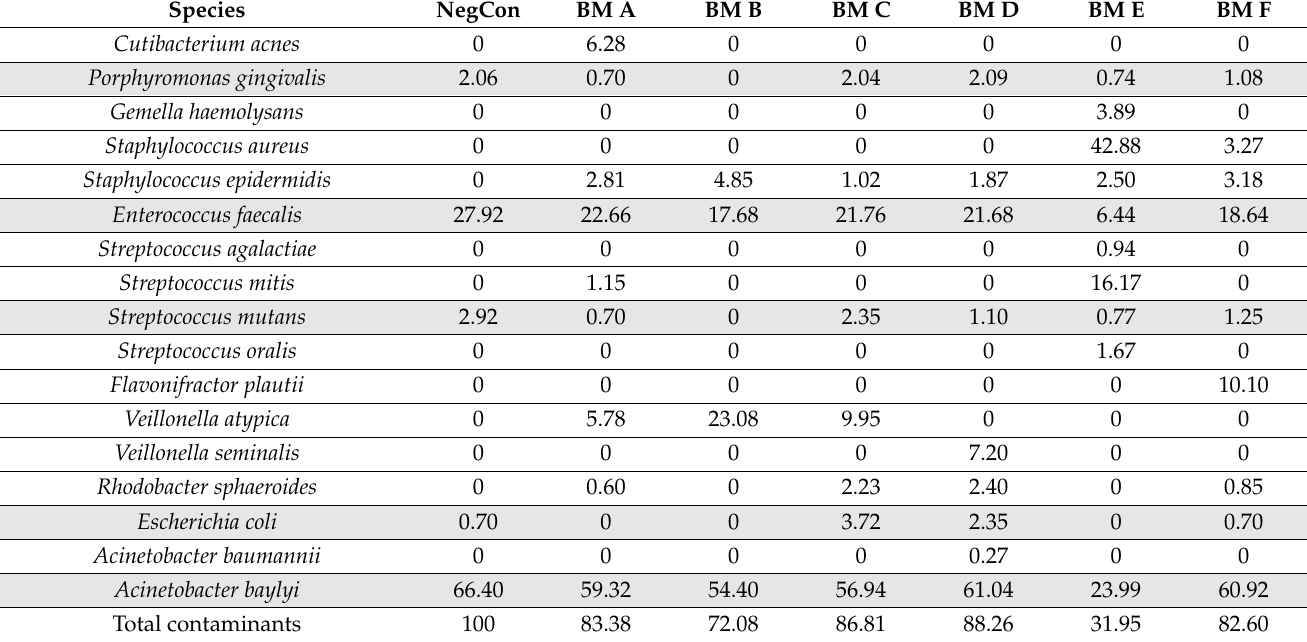
Table 4. Composition of the breastmilk microbiota and negative control as sequenced by Facility A and determined by MetaPhlAn3 [39]. Values represent percentage relative